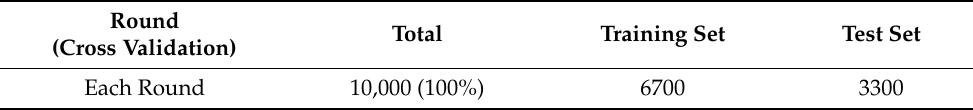
Table 3. The number of training and testing data sets after each round of segmentation.